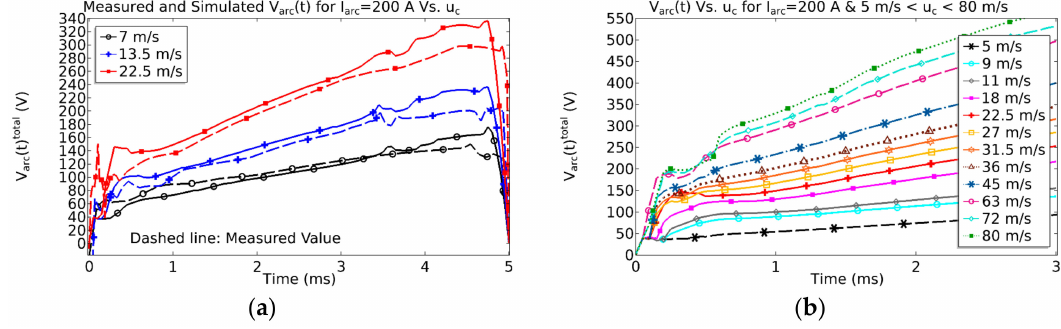
Figure 16. ( a ) V Meas and V simulated for u c = 7, 9, 13.5, and 22.5 m / s, ( b ) V simulated in first 1.5 ms for u c = 5–80 m / s, for 200 A peak